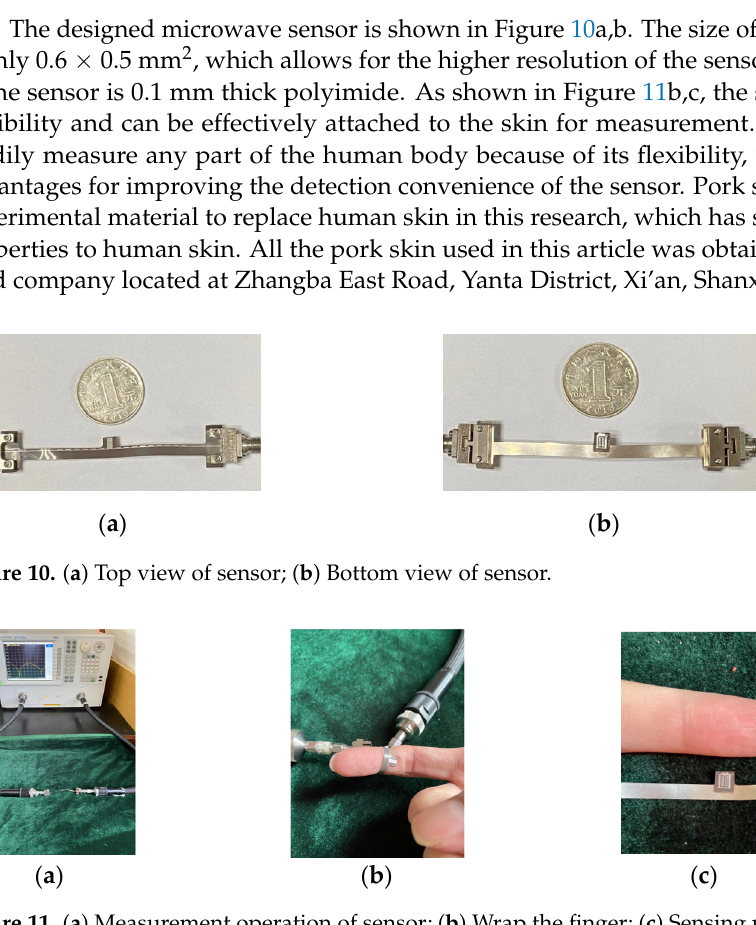
Figure 9. ( a ) Operation before measurement; ( b ) Measurement operation diagram.